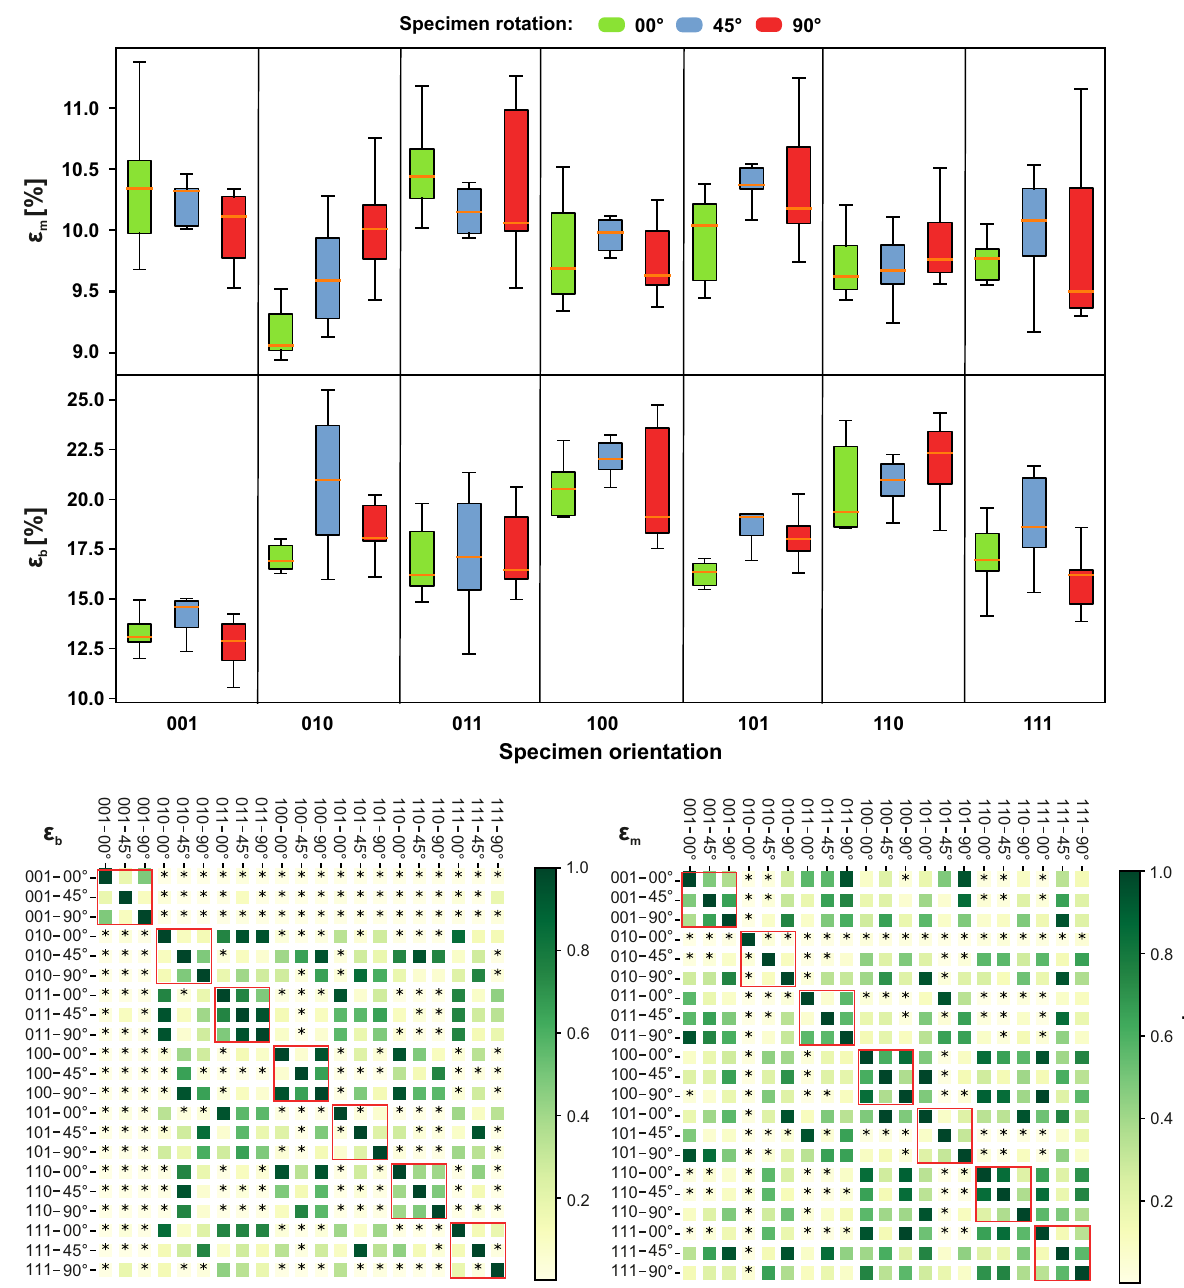
Figure 13. Impact of different sample orientations on the ultimate strain ( ε m ) and strain at break ( ε b ) values. The red border in the heatmap highlights specimens with equal orientation. The members marked as * express a statistically significant